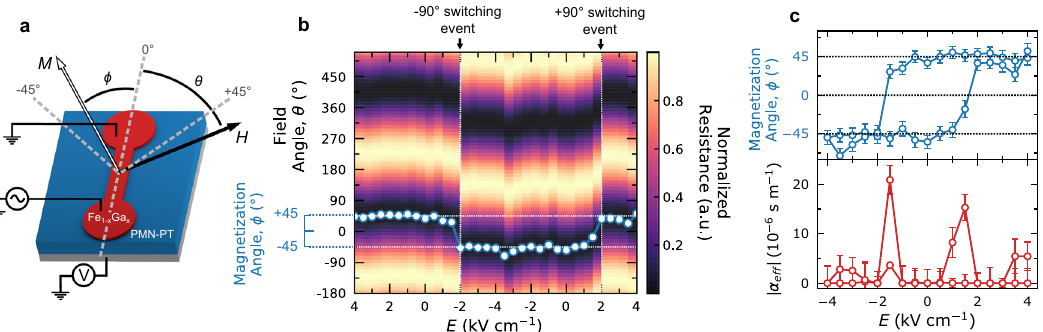
Fig. 2 Magnetoelectric switching. a Schematic of the Fe 1 − x Ga x /PMN-PT device. Voltage is applied across the substrate, using the device as a top ground, and resistance is measured along the bar as a function of magnetic fi eld strength and direction ( ϕ ). b Colormap of low- fi eld (50 Oe) AMR curves fi t to cos 2 θ ð Þ , showing the normalized resistance as a function of magnetic fi eld direction ( θ ) and applied electric fi eld. The overlain points correspond to the calculated phase shift from the data, which is the direction of magnetization, ϕ . The two saturated polarization states of the ferroelectric show a 90 (cid:3) phase shift in the curve, demonstrating a 90 (cid:3) switching of magnetization. c Hysteresis of the anisotropy axis, with respect to the direction of the device (x), as a jÞ , reaching a maximum value of ~2.0 × 10 − 5 s m − 1 during switching. The function of electric fi eld, and effective converse magnetoelectric coef fi cient ðj α eff error bars represent the ± 5 (cid:3) angular resolution with one standard deviation of the fi t to cos 2 θ ð Þ . Parts ( b ) and ( c ) show the representative 30% Ga sample with the largest magnetoelectric coef fi cient. The full data set is shown in Sup. Fig.